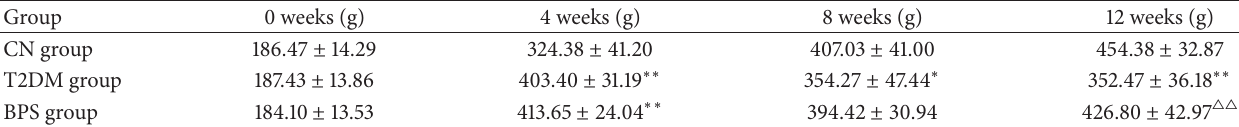
Table 2: Changes in body weight of rats in experiment ( 𝑛 = 6 , 𝑋 ± 𝑆